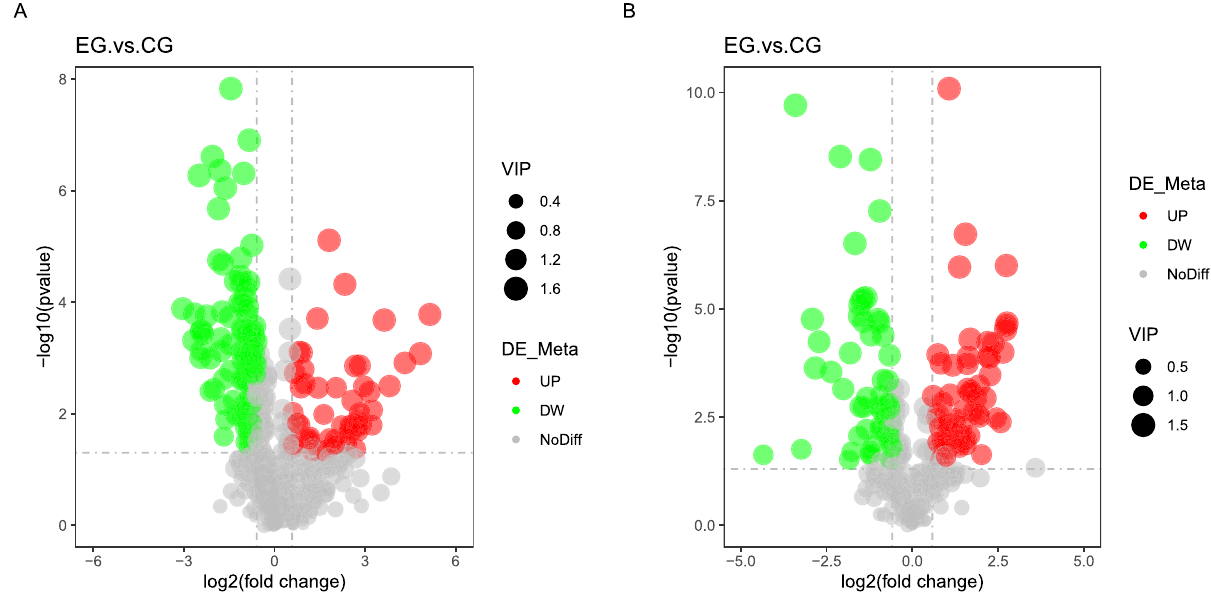
Figure 5. Analysis of the differential metabolites in cells cultured in a basket bioreactor. ( A ) Volcano diagram of the differential metabolites in positive ion mode. ( B ) Volcano diagram of the differential metabolites in negative ion mode. The abscissa displays the expression fold change (log 2 FC) of metabolites in different groups, and the ordinate displays the level of significant difference (− log 10 (p value)). Each point in the graph represents a metabolite, and the size of the point represents the VIP value. The significantly upregulated metabolites are represented by red points, and the significantly downregulated metabolites are represented by green points. VIP variable importance in projection reflecting the contribution of the quantitative value of each sample to the difference, generally set to VIP > 1, DE_Meta differential expression of metabolites.